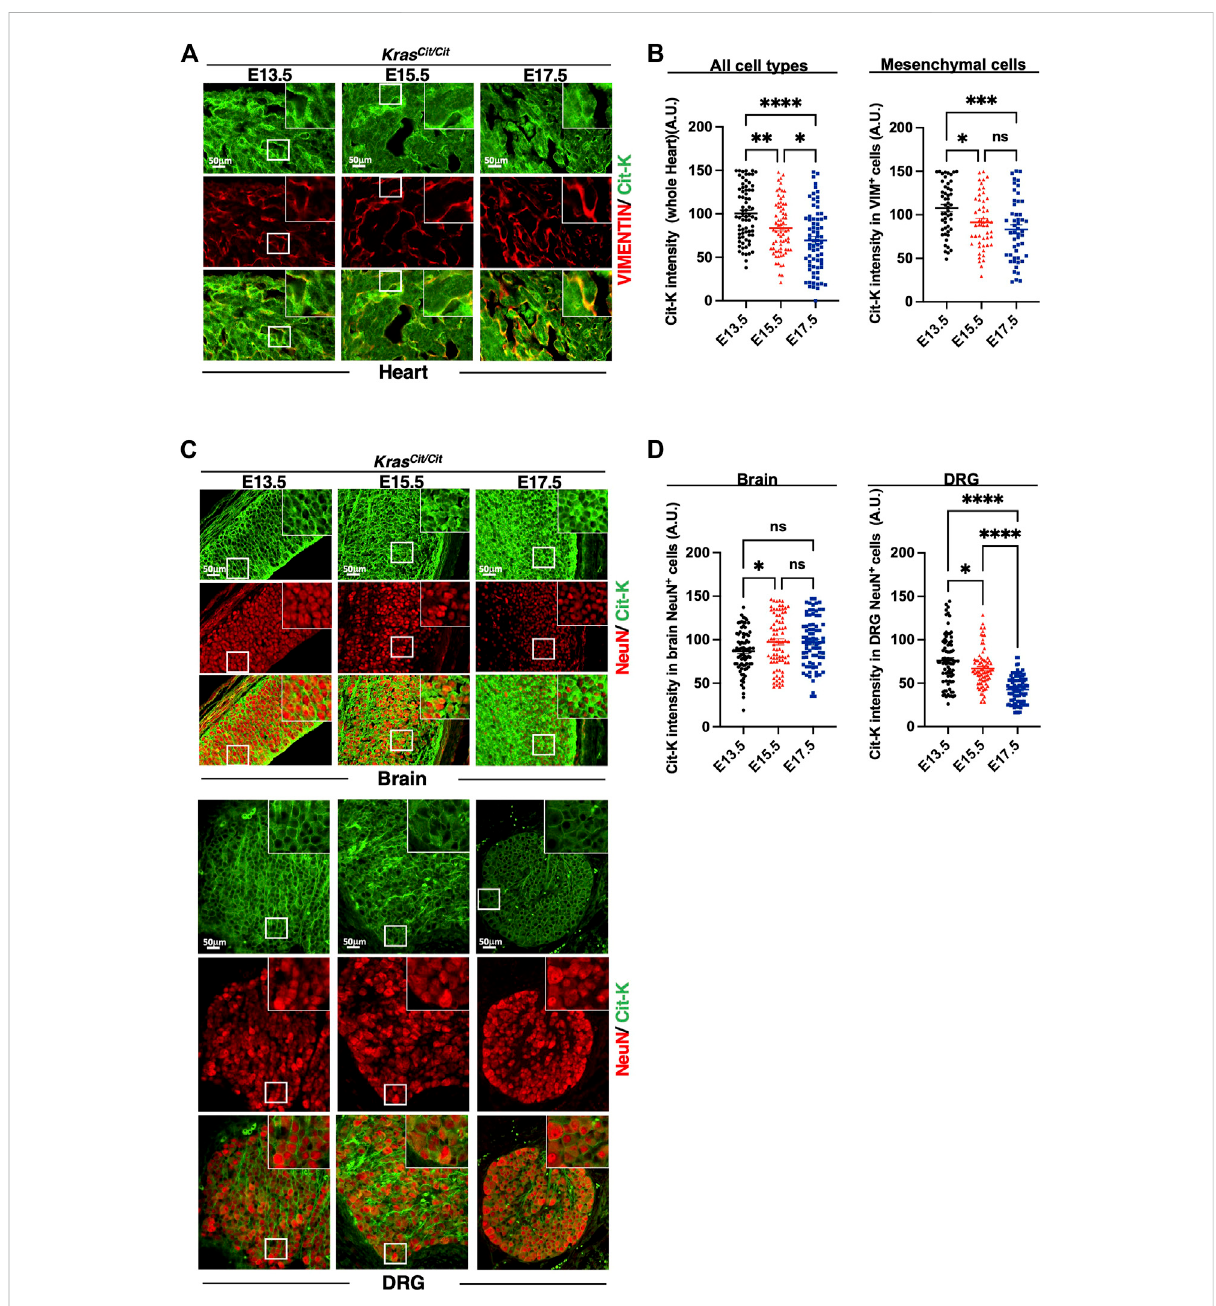
Cit-K expression is present in heart, dorsal root ganglion (DRG), and brain. (A) Immunolabeling for Cit-K and VIMENTIN (VIM) on heart sections of Kras Cit/Cit embryos at E13.5, E15.5 and E17.5. (B) Quanti fi cation by FIJI software of Cit-K signal intensity in whole heart tissue and mesenchymal (VIM + ) cells. Data are represented as mean+/-SEM of 80 (n = 4 embryos). (C) Immunolabelling for Cit-K and NeuN (epithelial neuronal cell) on brain and dorsal root ganglion (DRG) sections of Kras Cit/Cit embryos at E13.5, E15.5 and E17.5. Comparison between DRG sections of Kras +/+ and Kras Cit/Cit embryos (not shown) indicate that strong Cit-K labeling observed in nervous fi bers is non-speci fi c and can be explained by the auto- fl uorescenceofnervous fi bers. (D) Quanti fi cationbyFIJIsoftwareofCit-Ksignalintensityinepithelialneuronal(NeuN + )cells.Onedotrepresentsthe mean of three measures of signal intensity in one cell. Data are represented as mean+/-SEM of 80 cells (n = 4 embryos). Statistical signi fi cance was tested by Student ’ s t -test. *, p < 0.05; ***, p < 0.001; ****, p < 0.0001 and ns, not signi fi cant. A.U. arbitrary